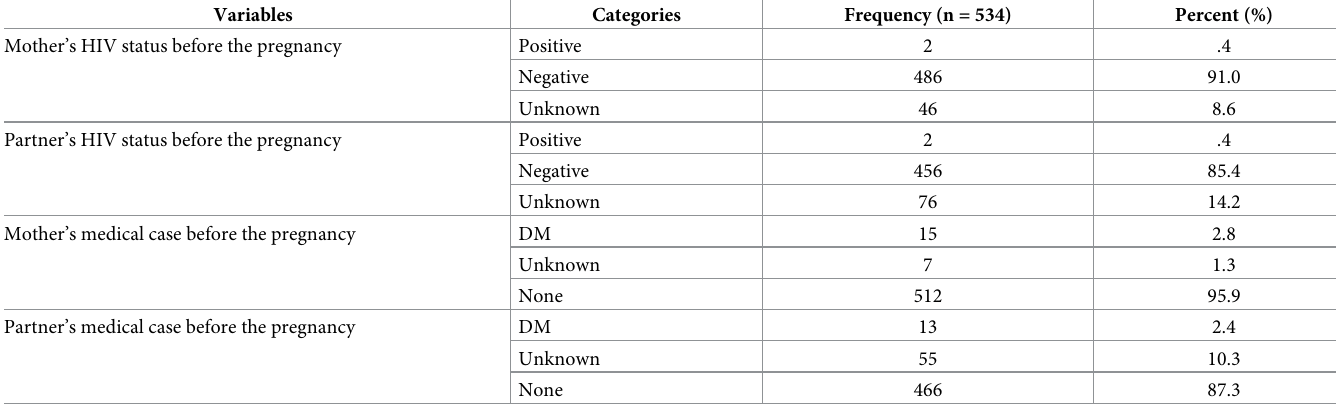
Table 4. Medical-related problems of mothers with natural planned conception attended ANC service at AMHFs, 2020.